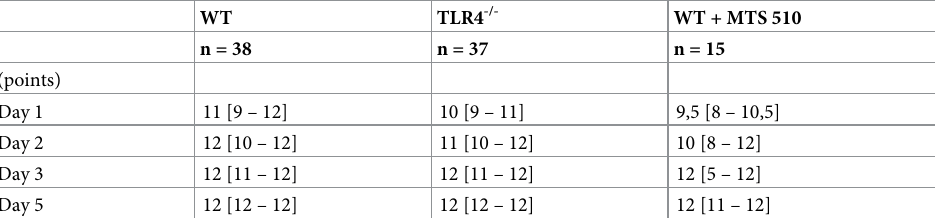
Table 2. Neuro score.